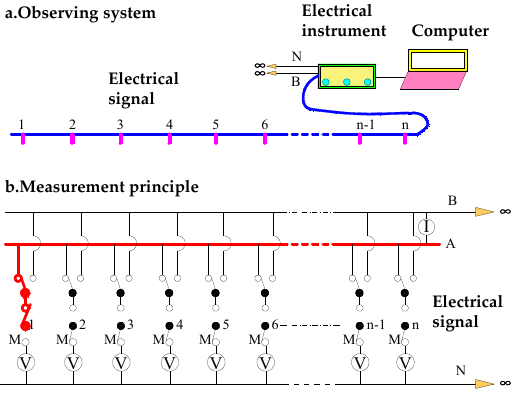
Figure 5. The principle of single-point power supply field measurement.